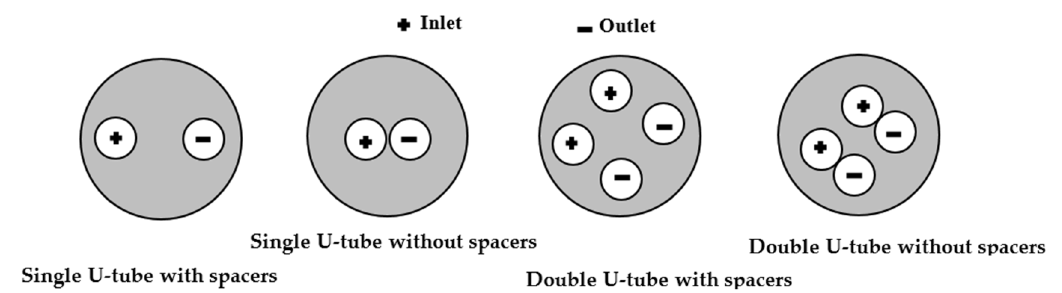
Figure 12. The position of the single and double U-tube with and without spaces.